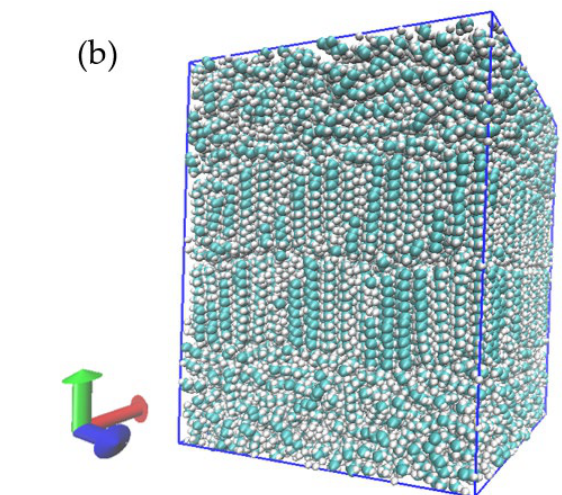
Figure 3. Percentile of crystallized C18 molecules in simulation box for ( a ) no NA, ( b ) Na with a surface consisting of chain ends, ( c ) NA with surfaces consisting only of chain sides, ( d ) small NA with surfaces of both chain sides and ends and ( e ) a large NA with surfaces of both chain sides as well as ( f ) the simulated C18 system with boxes indicating the initial NA.